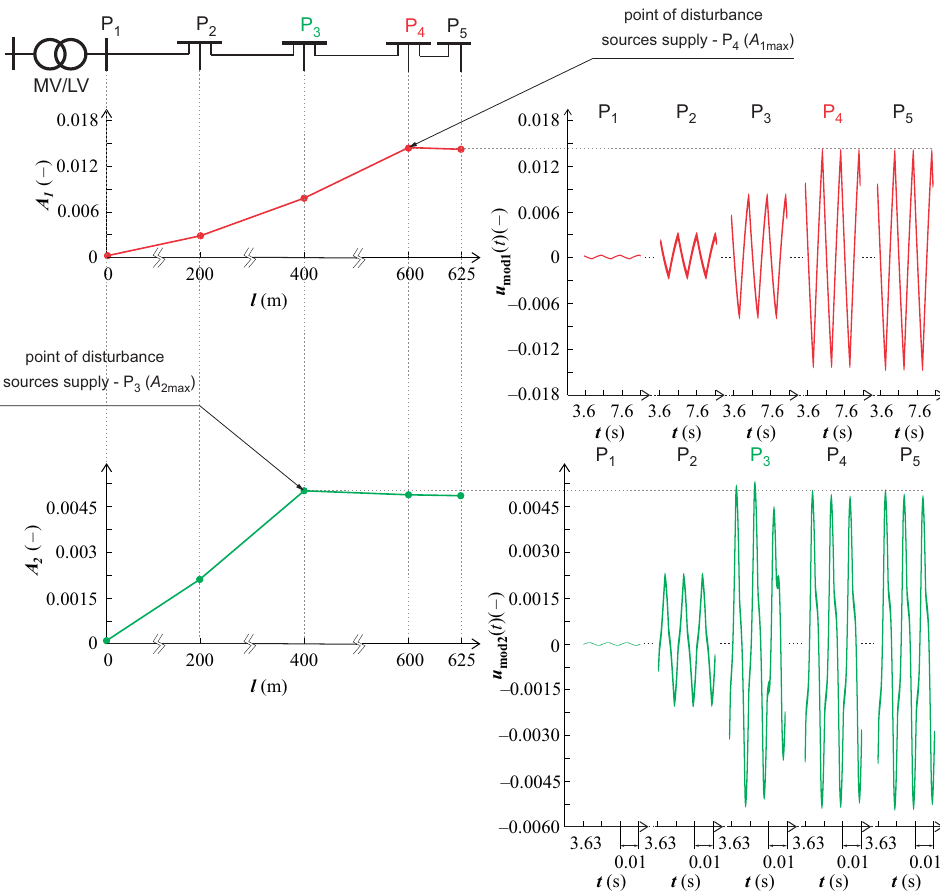
Figure 7. Graphical representation of the proposed approach for Case I and for Line